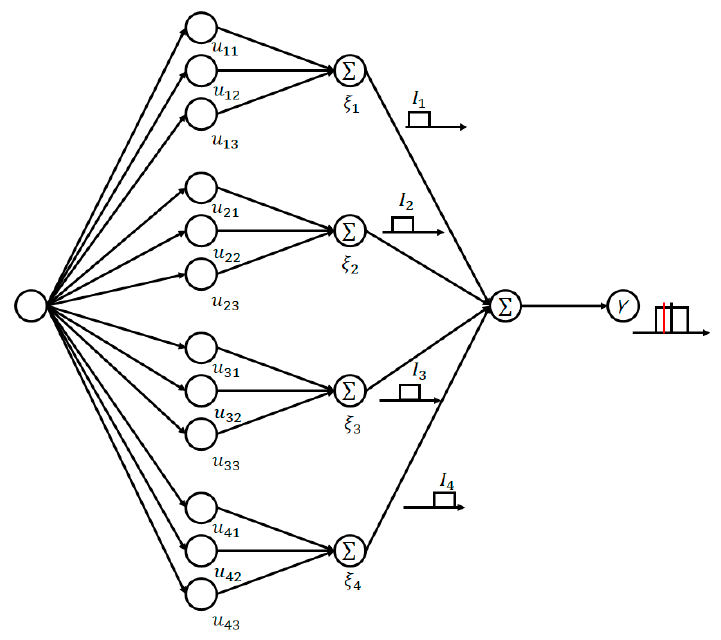
Figure 3. Architecture of interval-based granular model (GM).